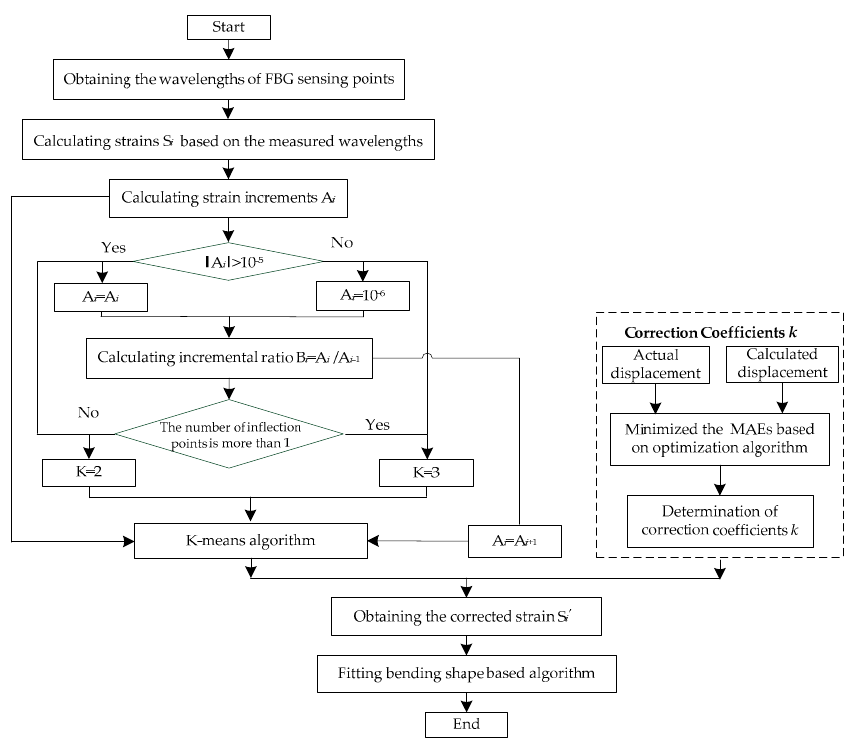
Figure 4. Flow chart of the segmental correction method based on strain increments at sensing points.